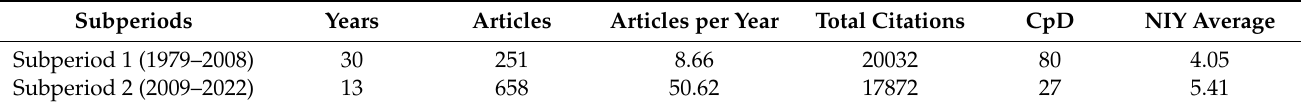
Table 1. Published articles, citations and NIY. Detail by subperiods.